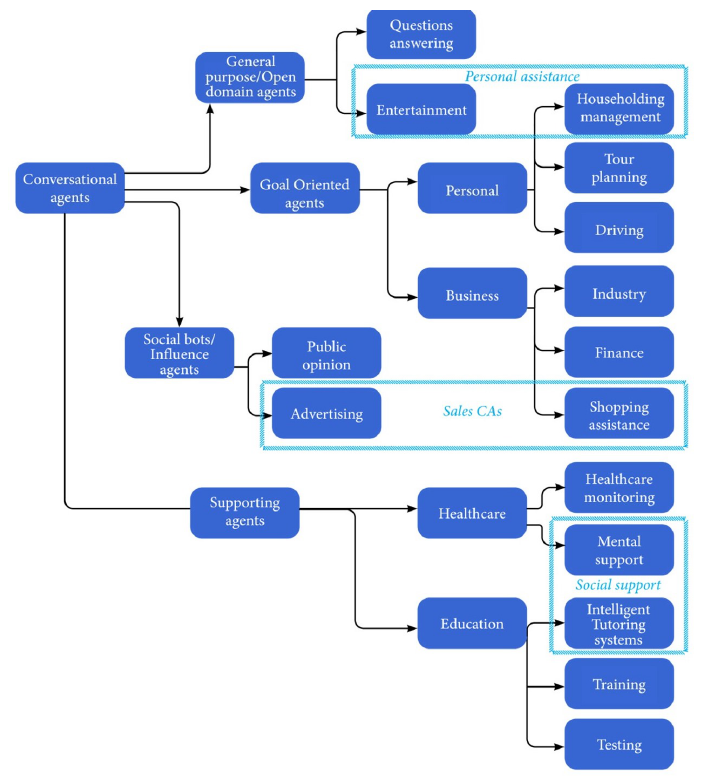
Figure 3. Conversational-agent